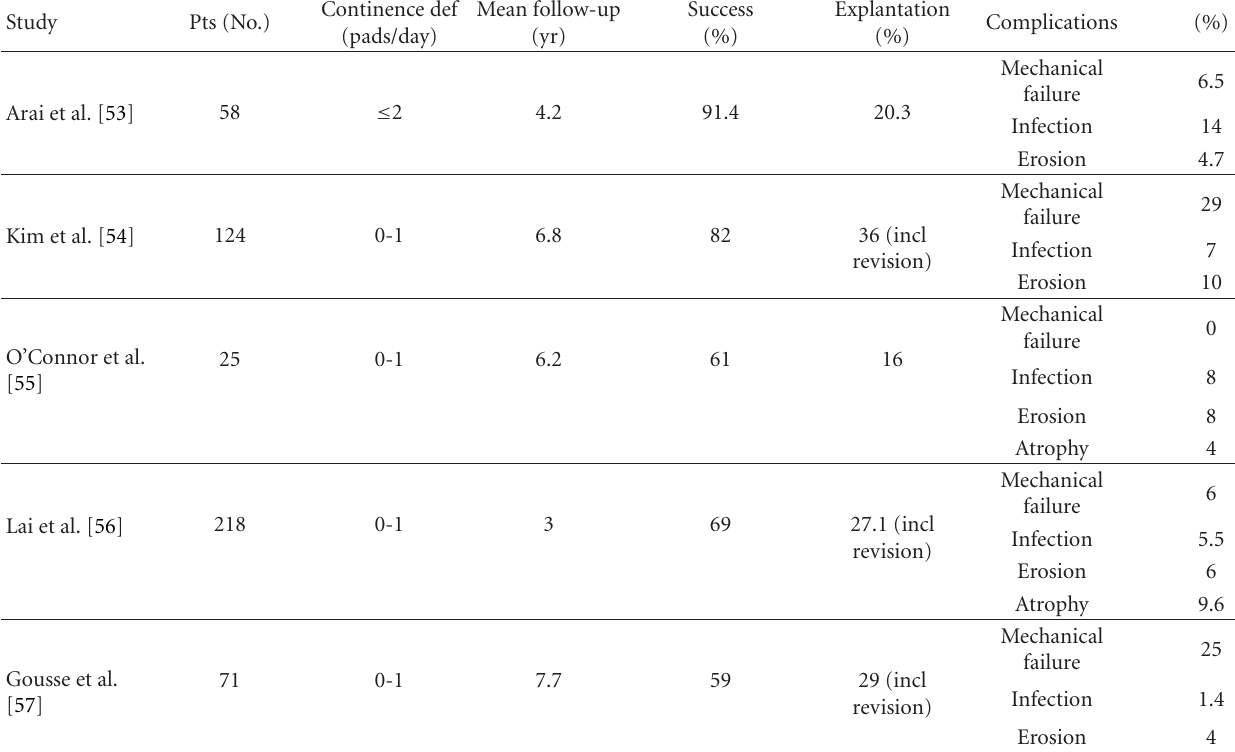
Table 4: Comparison of results of single-cu ff AUS placement in adult males with